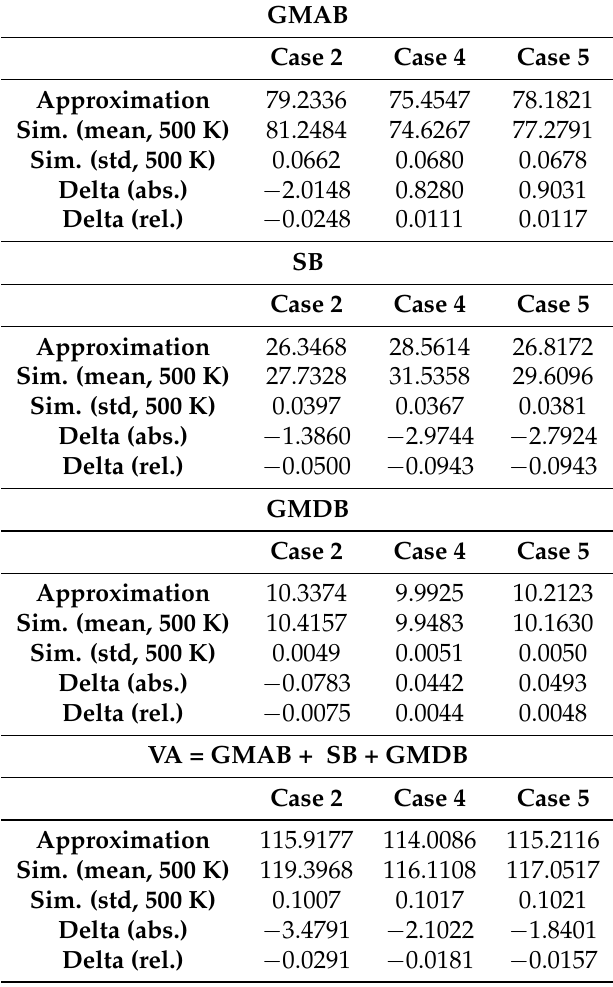
Table 9. VA Prices, Standard Deviations and